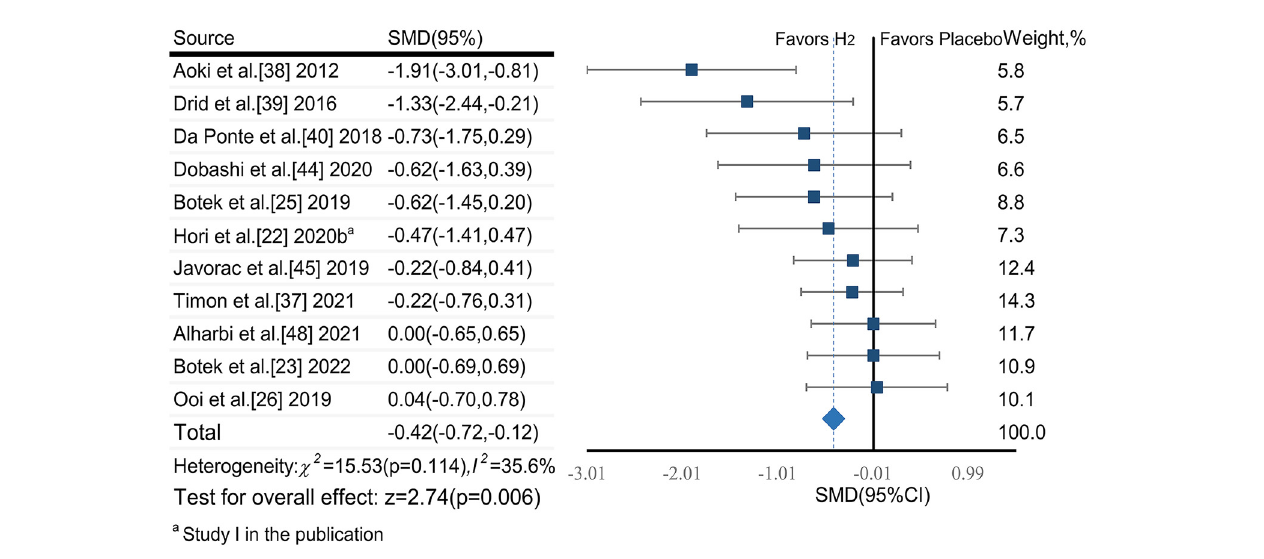
FIGURE4 The pooled effect size of H 2 intake on blood lactate.